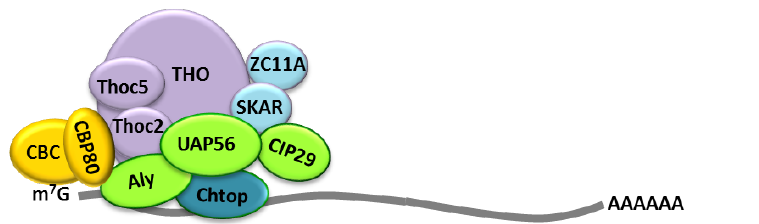
Figure 1. Formation of transcription-coupled export (TREX) on the 5'-end of the mRNA through direct interactions with the cap-binding complex